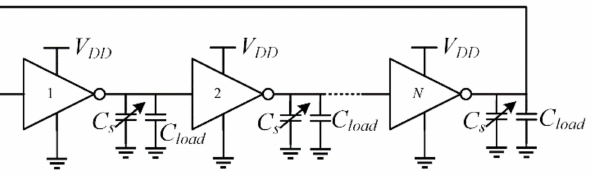
Figure 2. Simplified schematic of the sensing oscillator (reference oscillator has the same topology but with C s = C r